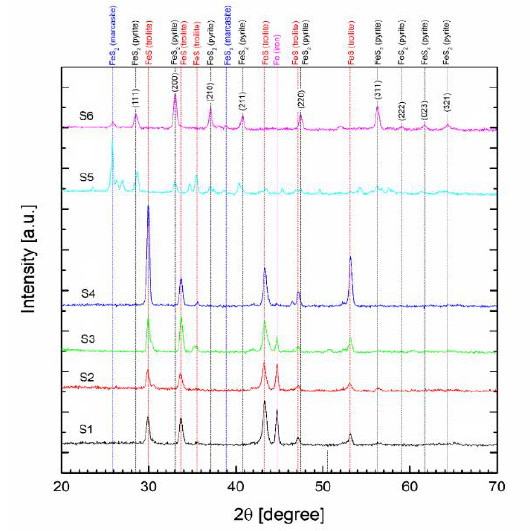
Figure 8. XRD di ff raction patterns for the samples S1–S6 from Table Figure 8. XRD diffraction patterns for the samples S1 – S6 from Table 1.